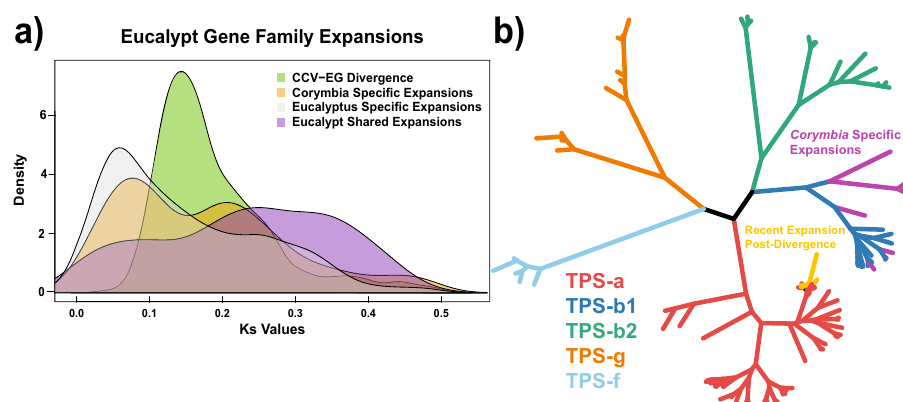
Fig. 5 Relative timing of eucalypt gene family expansions. a Synonymous substitution rates (Ks) among orthologs derived from shared eucalypt expansion and those that are E. grandis and C. c. variegata speci fi c. Green distribution- Corymbia - Eucalyptus divergence peak among orthologs. Gray distribution- E. grandis expanded orthogroups. Orange distribution- C. c. variegata expanded orthogroups. Purple distribution- E. grandis and C. c. variegata shared expanded orthogroups. b C. c. variegata terpene gene families. Red branches- Terpene synthase family-a genes. Blue branches- Terpene synthase family-b1 genes. Green branches- Terpene synthase family-b2 genes. Orange branches- Terpene synthase family-g genes. Light-blue branches- Terpene synthase family-f genes. Purple branches- Terpene synthases that are generally expanded in C. c. variegata . Yellow branches- Terpene synthases that expanded after C. c. variegata diverged from E. grandis